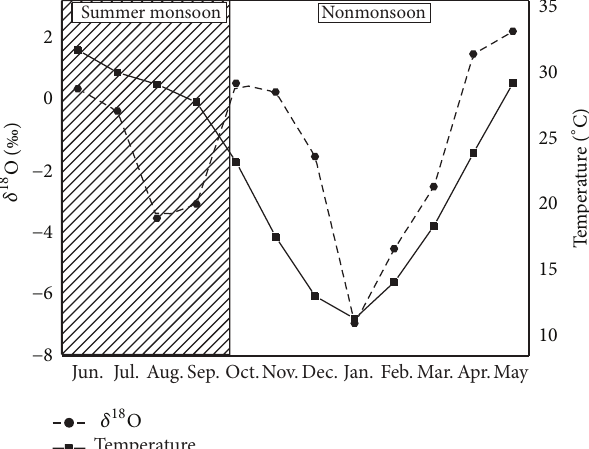
Figure 8: Seasonal isotopic variation in the rainfall water of Islamabad.